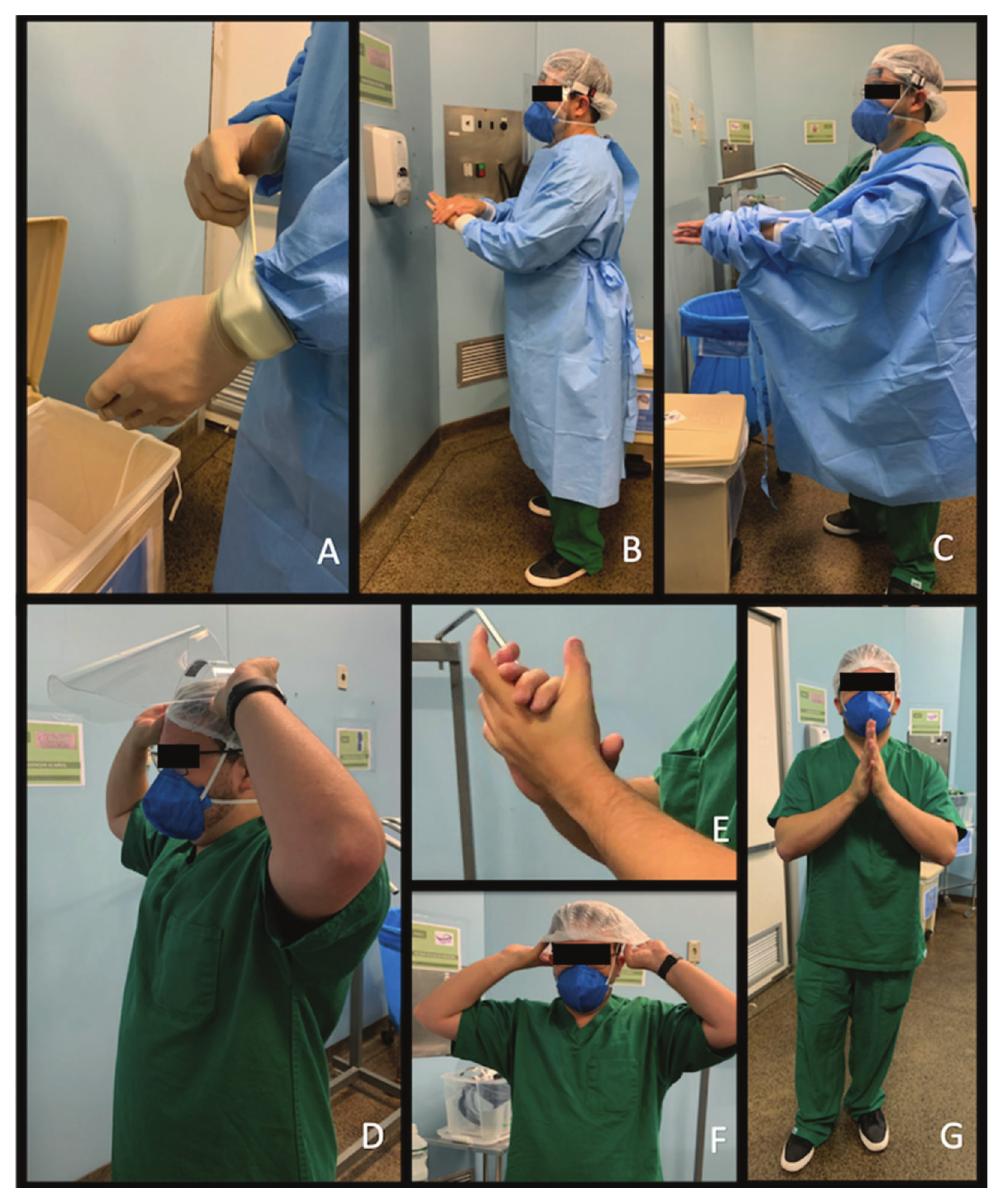
Figure 4 - Guidance on Removing PPE to be used by Healthcare Professionals during Endoscopic Procedures for Patients with Confirmed/Under Investigation for COVID-19. After the procedure, the professional should go to the dressing room (donning/doffing room) and: A. remove gloves; B. hand hygiene; C. remove and discard gown; D. remove face shield and googles; E. hand hygiene; F. discard hairnet and put on a new one; and G. hand hygiene. After these steps, the healthcare professional may leave the surgical